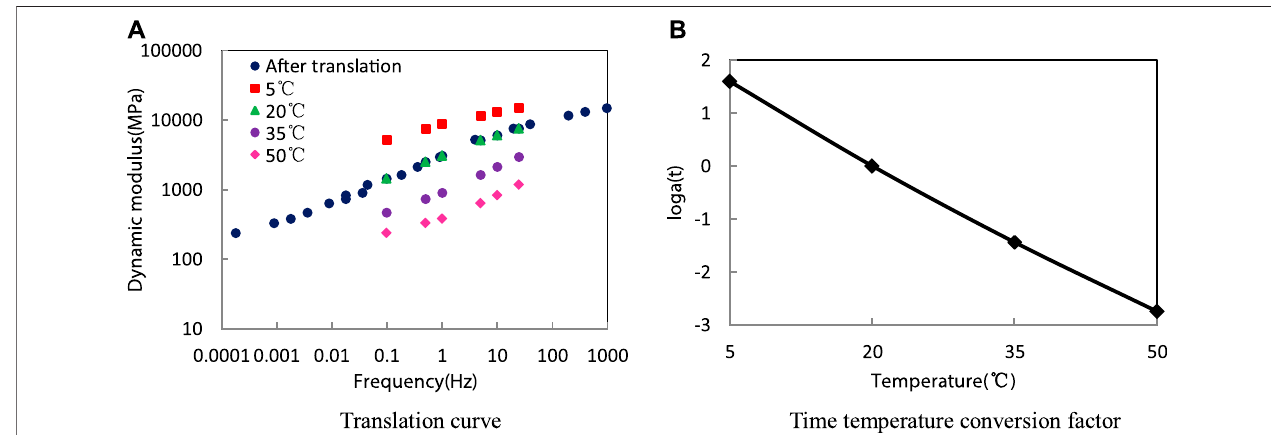
FIGURE7 | ARHM20 translation curve.